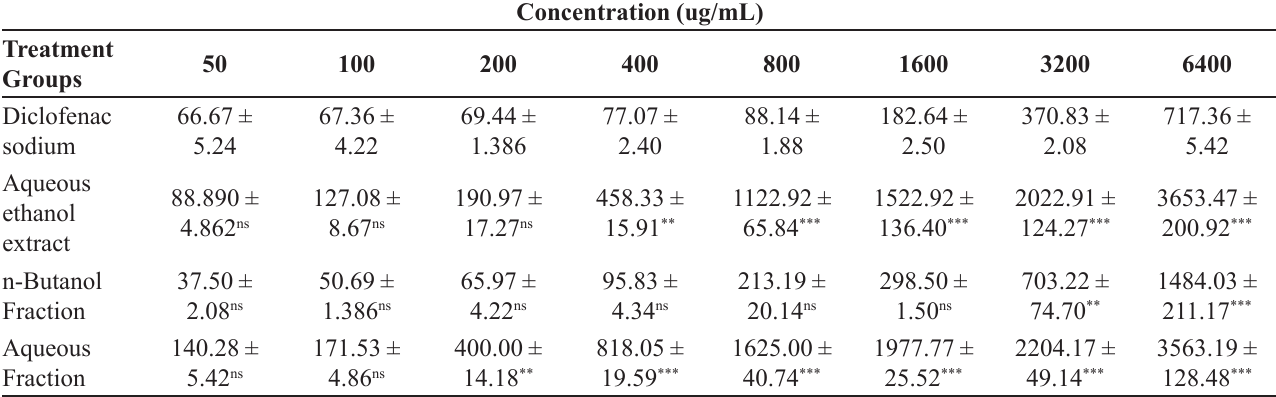
TABLE II - Effect of Ribes alpestre on inhibition of protein (Egg albumin) denaturation Percentage protection against protein denaturation Concentration